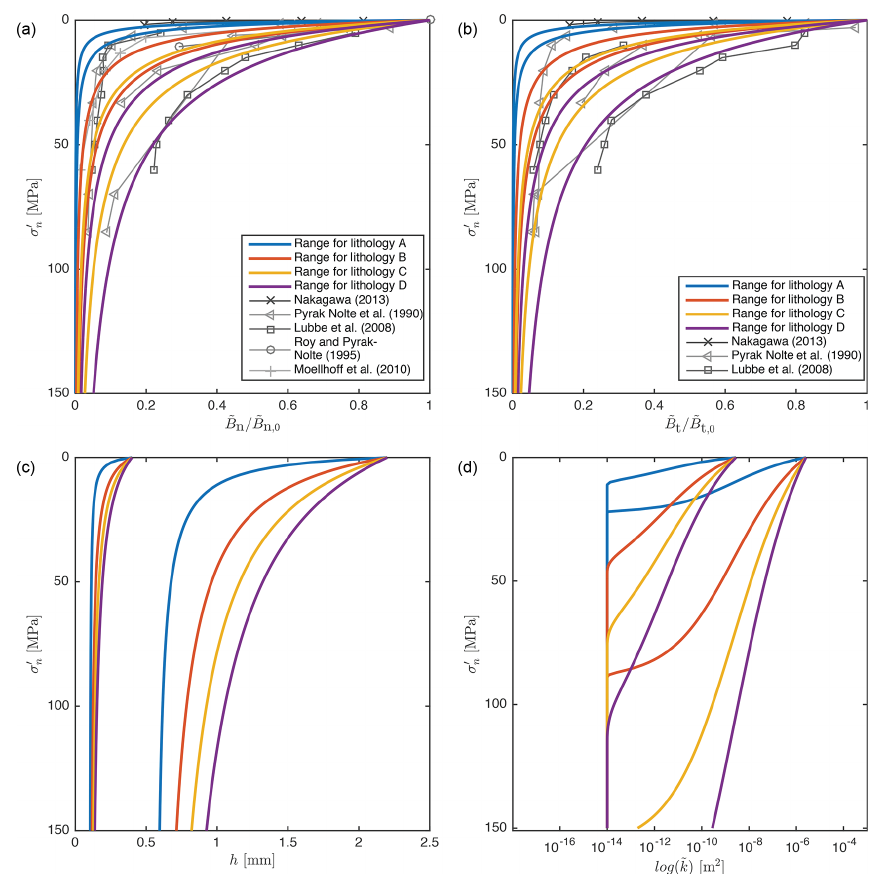
Figure 9. Normalized normal (a) and tangential (b) compliances, fracture aperture (c) , and hydraulic permeability (d) versus effective normal stress. Gray graphs in (a) and (b) are the experimental observations reported in the literature. Colored graphs are the analytical calculations for lithologies A–D, where for each lithology the maximum and minimum values are given, since all properties vary depending on the fracture aspect ratio or fracture